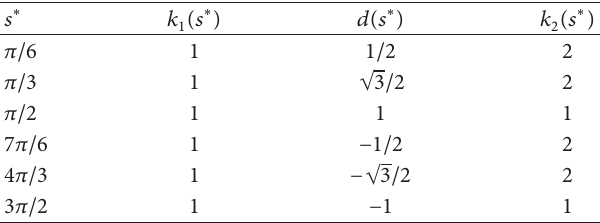
Table 1: The values of 𝑠 ∗ , 𝑑(𝑠 ∗ ) , 𝑘 1 (𝑠 ∗ ) , and 𝑘 2 (𝑠 ∗ ) .